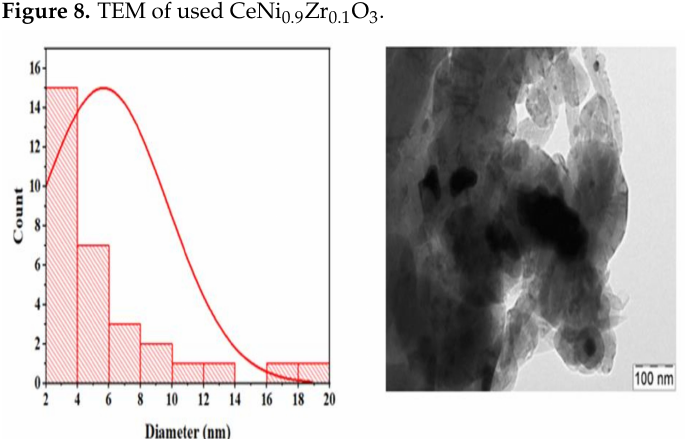
Figure 8. TEM of used CeNi 0.9 Zr 0.1 O 3 .